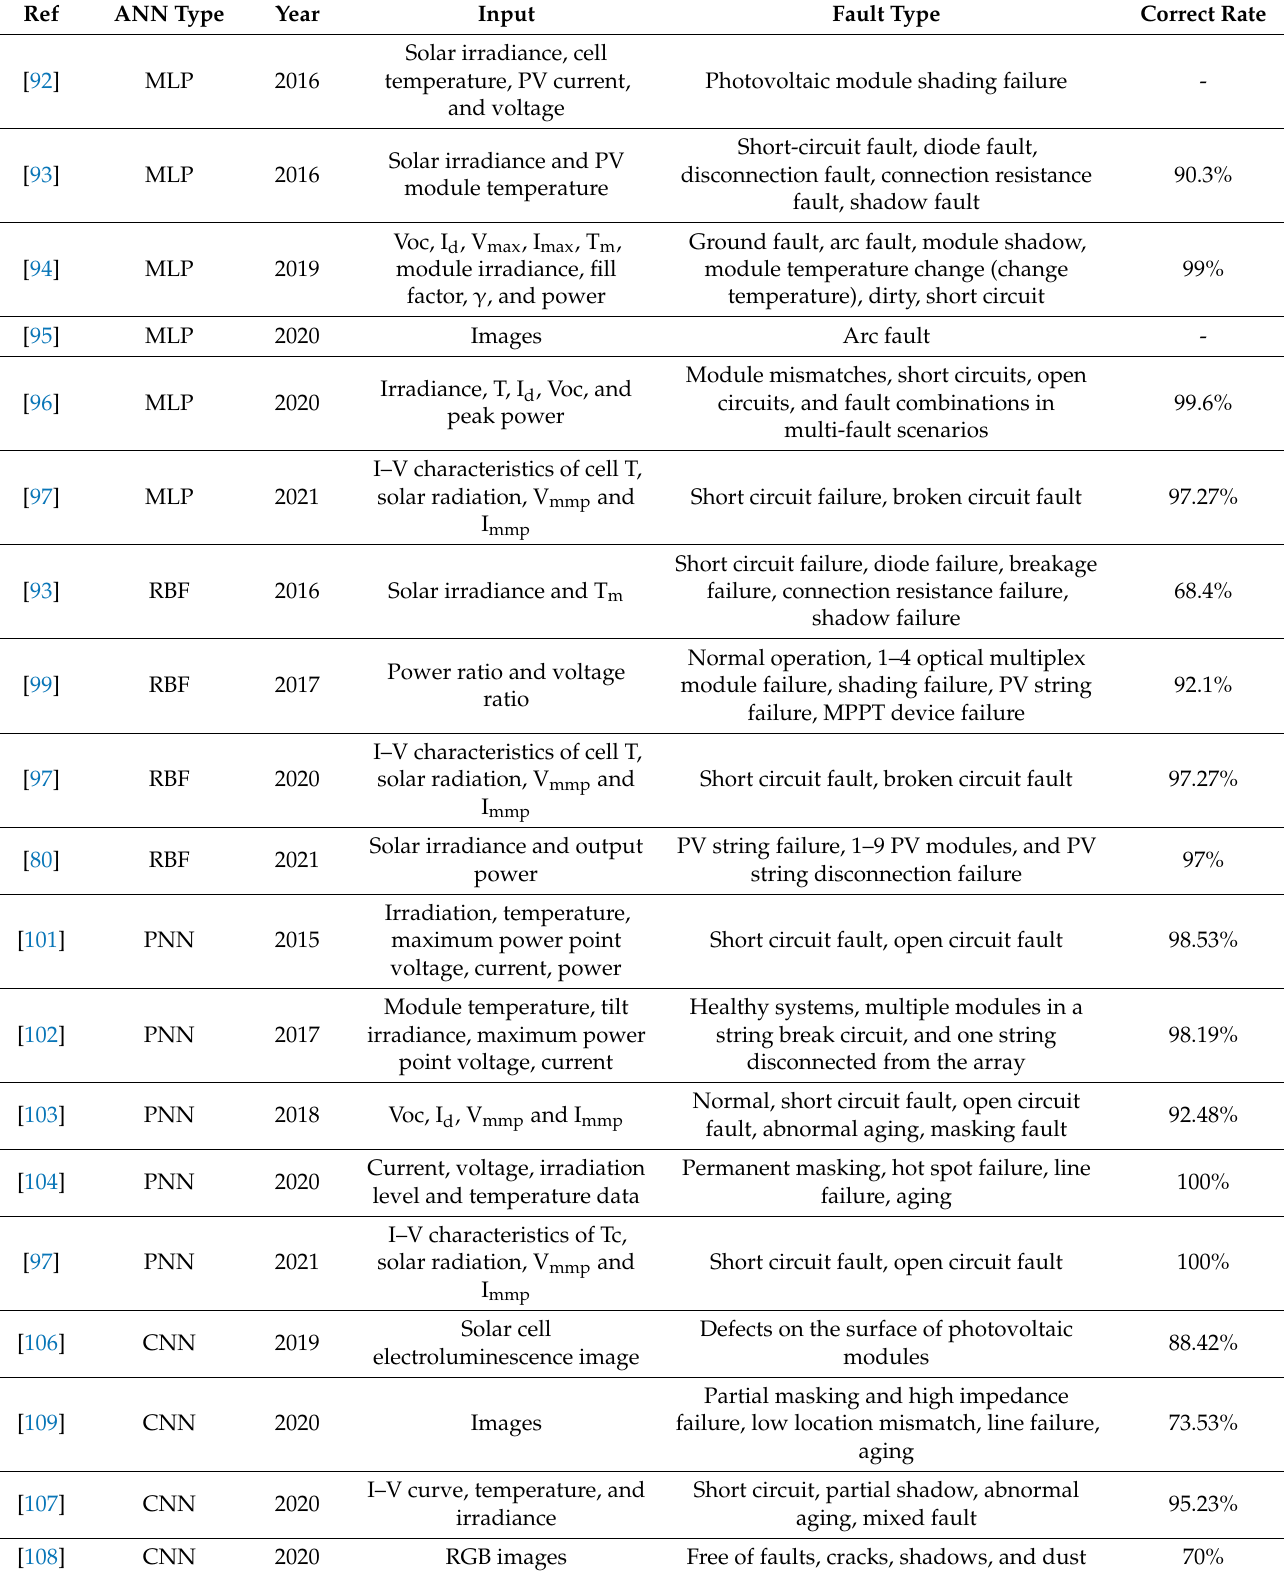
Table 1. Summary of application of ANNs to PV system fault